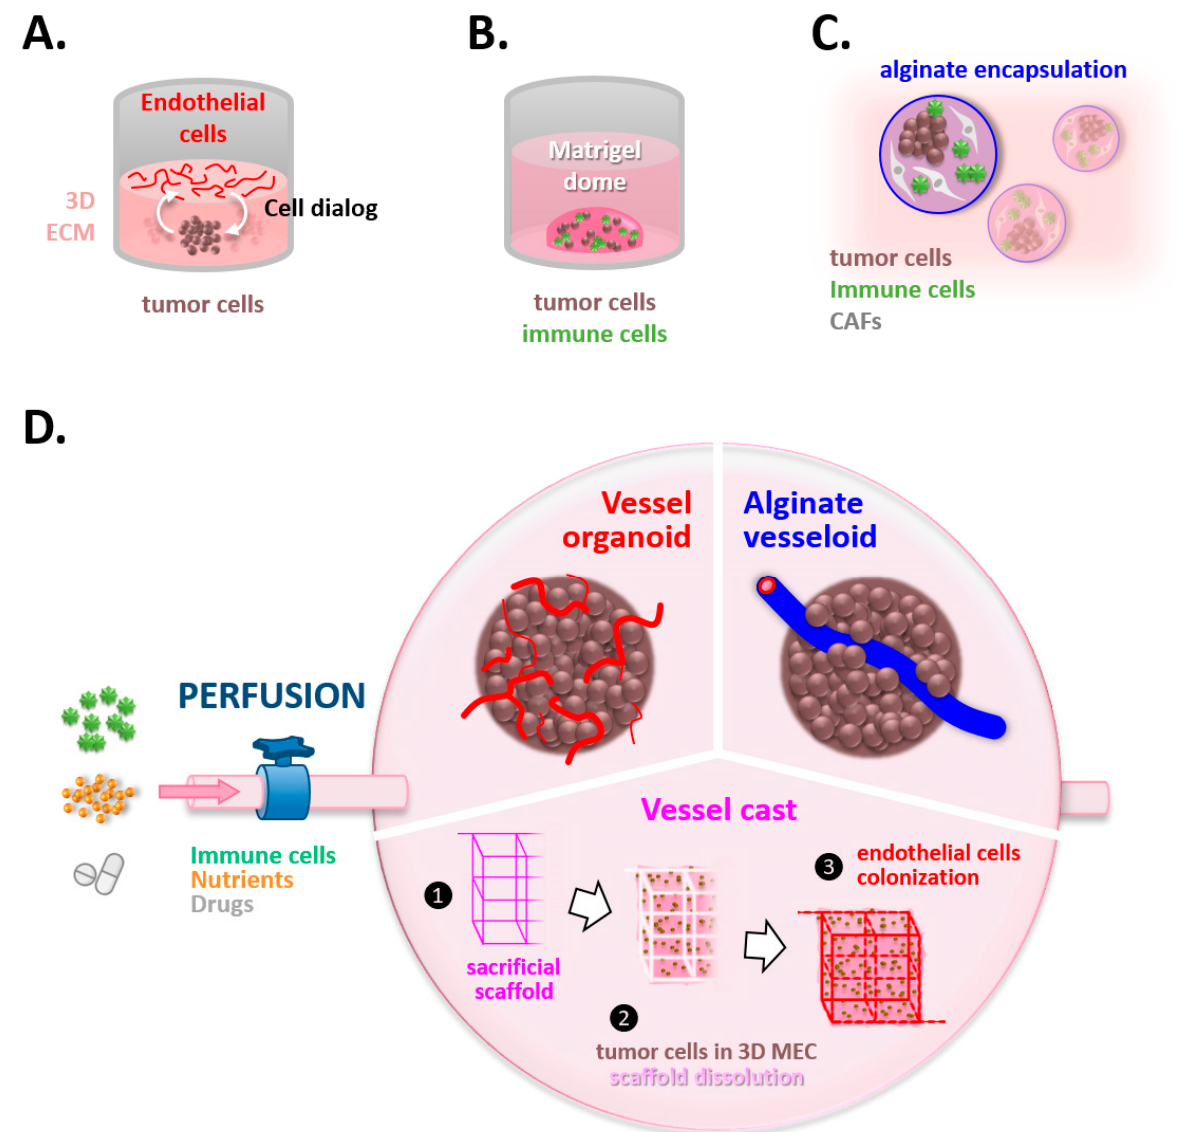
Figure 4. Welcome to the 3rd dimension. 3D models display a variety of opportunities to generate organized paracrine interactions. ( A ) ECM hydrogels can separate cell types to understand their paracrine interactions or migration. ( B ) Organoids preserve the tumor traits and their heterogeneity. ( C ) Alginate shells encapsulate cells and recreate a microenvironment in which cells produce their own ECM and self ‐ organize. ( D ) In all these settings, the introduction of a vascular network represents a great challenge and allows integration of angiocrine effects and the perfusion and delivery of nutrients, cells, and drugs.